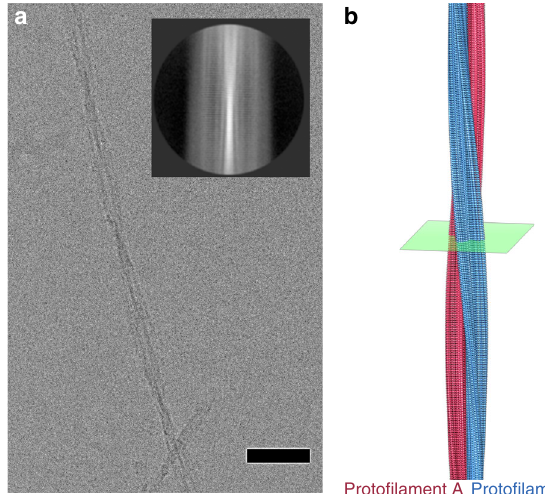
Fig. 2 The cryo-EM structure of a two proto fi lament β 2 m amyloid fi bril. a Raw cryo-EM image of a β 2 m fi bril in vitreous ice. The scale bar is 50 Å in length. Inset: an average of fi bril segments shows periodicity which is perpendicular to the fi bril long axis with a ~4.8 Å spacing. b One turn of the β fi bril, with the two proto fi laments coloured red and blue. 2 m amyloid